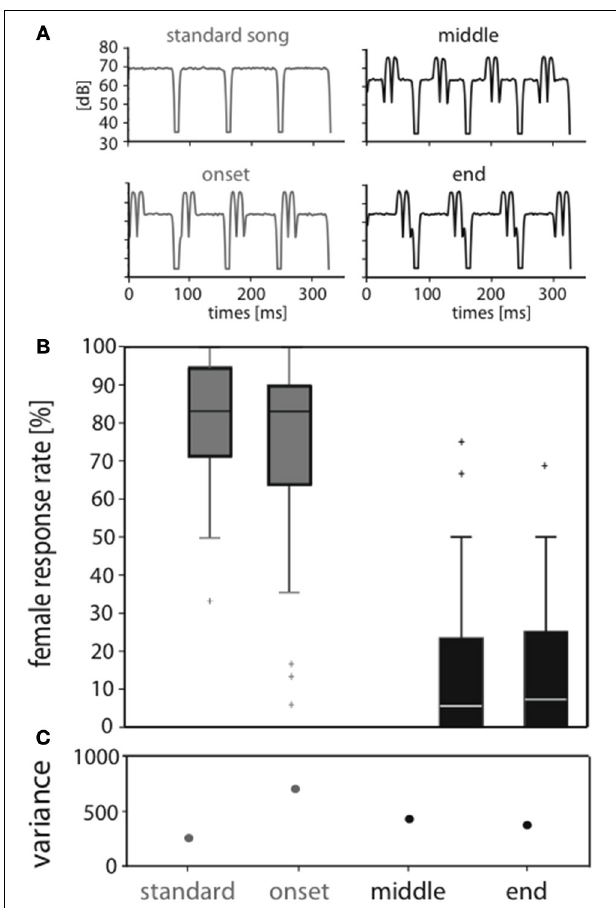
FIGURE 1 | Perturbation of the standard song affects attractiveness when placed at later syllable positions. (A) Envelopes of song models used for behavioral and neurophysiological tests. An attractive standard song consisted of 72ms syllables and 12ms pauses. The other stimuli had the same syllable and pause durations but exhibited perturbations at different positions within a syllable (onset, middle, end). (B) The median response rate of 33 C. biguttulus female responses for the stimulus with onset perturbation was 83%, thus very similar to the response to the standard stimulus. In contrast, stimuli with perturbation in the middle and end were mostly rejected (median response rate 6%). The median is displayed as the central mark in the box plot. The edges of the box are the 25 and 75th percentiles. (C) Note the high variance in female responses, especially when perturbation is at syllable